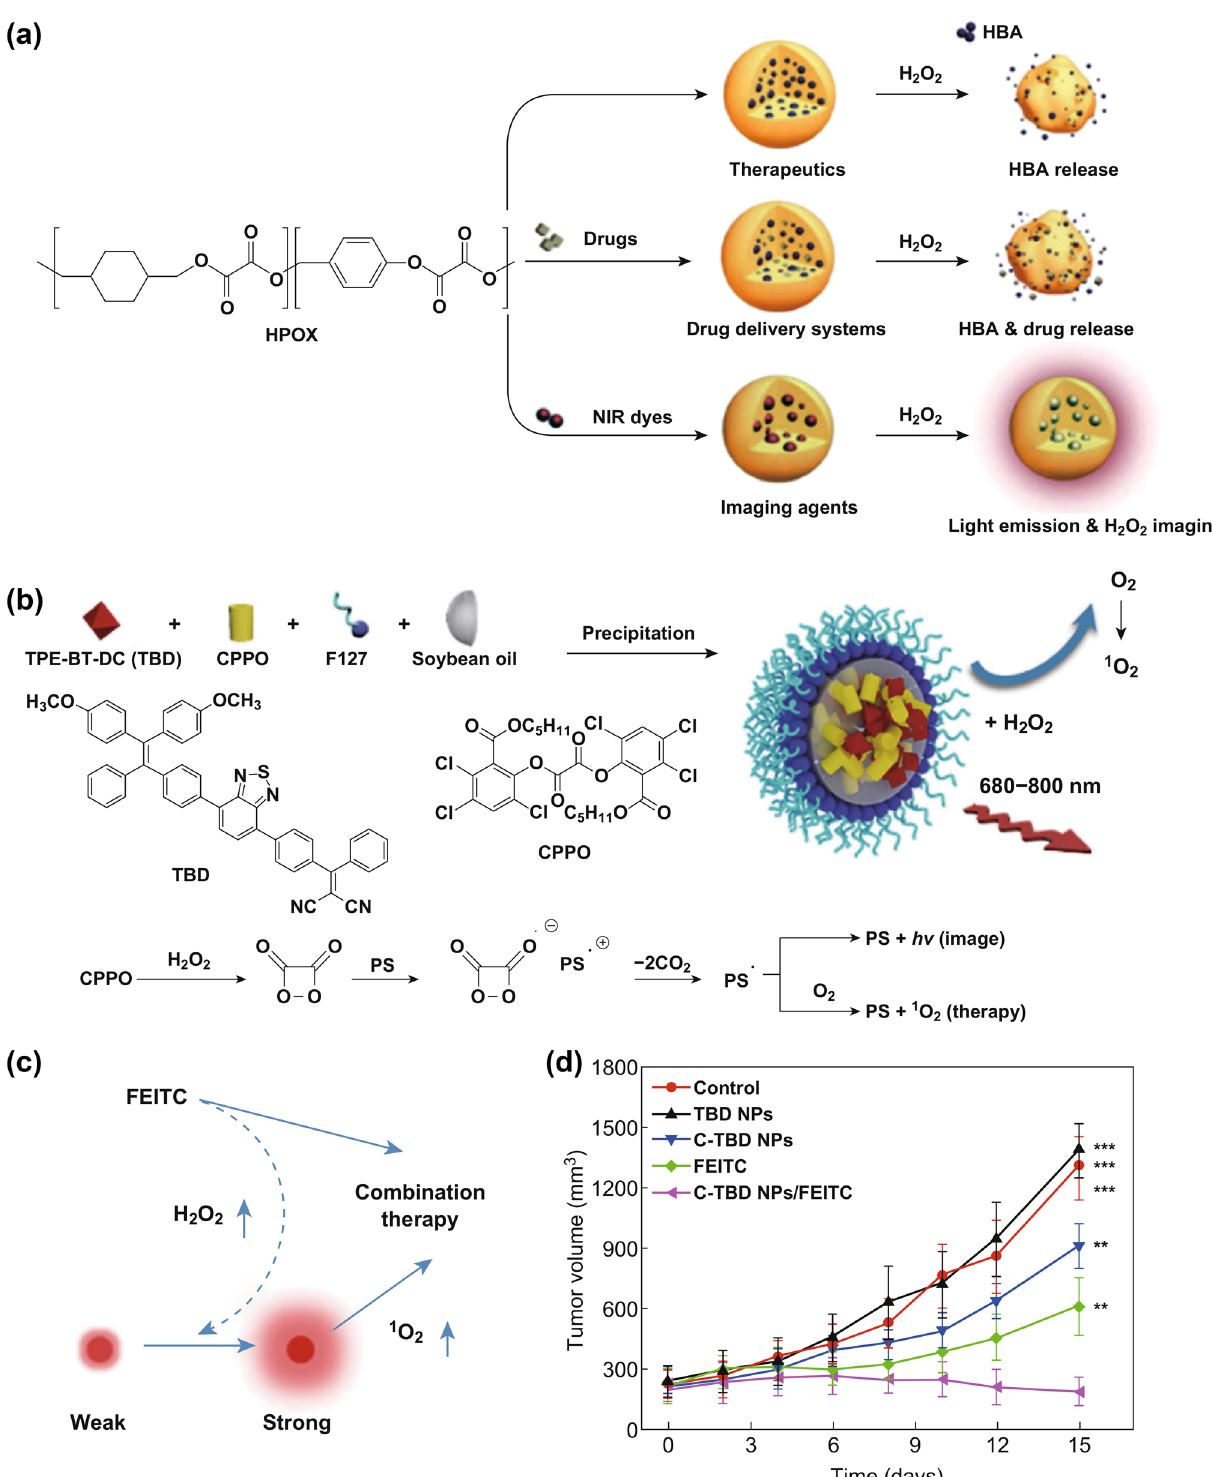
Fig. 10 a Multifunctional H 2 O 2 -activatable nanoparticles for bioimaging and therapy. Adapted with permission from Ref. [62]. Copyright 2013 Elsevier Ltd. b The preparation of C-TBD NPs and illustration of the principle for chemiluminescence and 1 O 2 generation of C-TBD NPs in the presence of H 2 O 2 . c Schematic diagram of the hypothetical mechanism of C-TBD NPs and FEITC combination therapy. d Tumor growth curves with different therapies. Adapted with permission from Ref. [63]. Copyright 2017 Elsevier